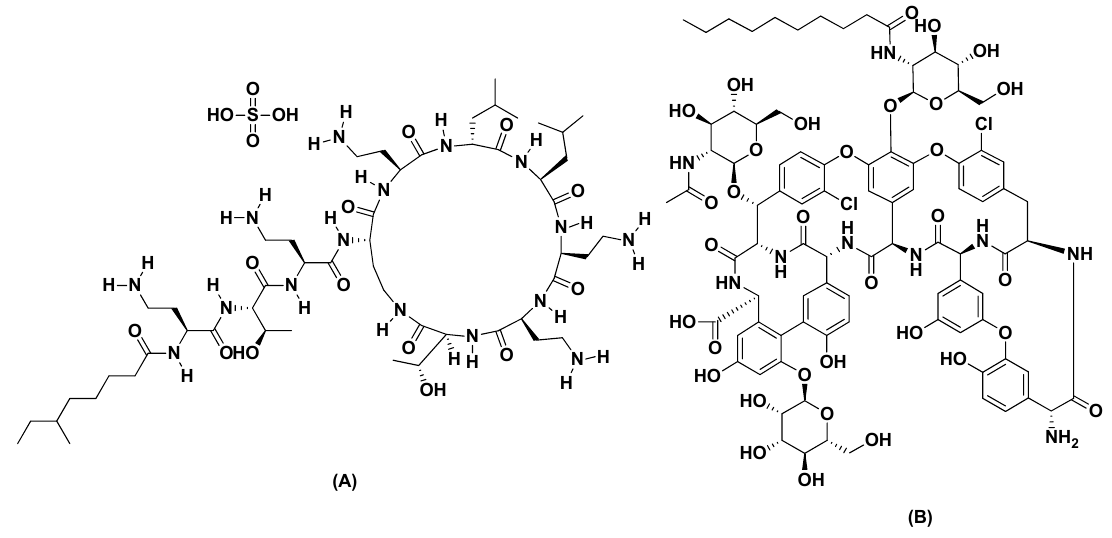
Figure 1. Chemical structure of colistin sulfate ( A ) and teicoplanin ( B ).